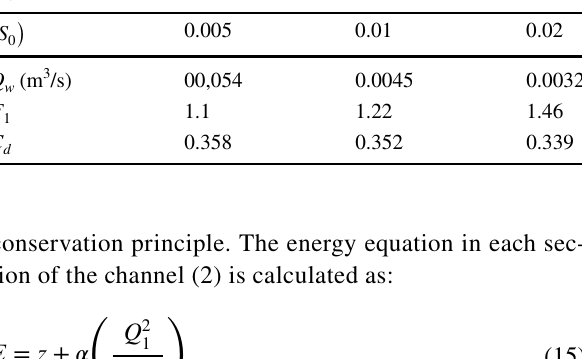
Table 4 Changes of Q w , F 1 , C d versus increasing of main channel bed ( S 0 )